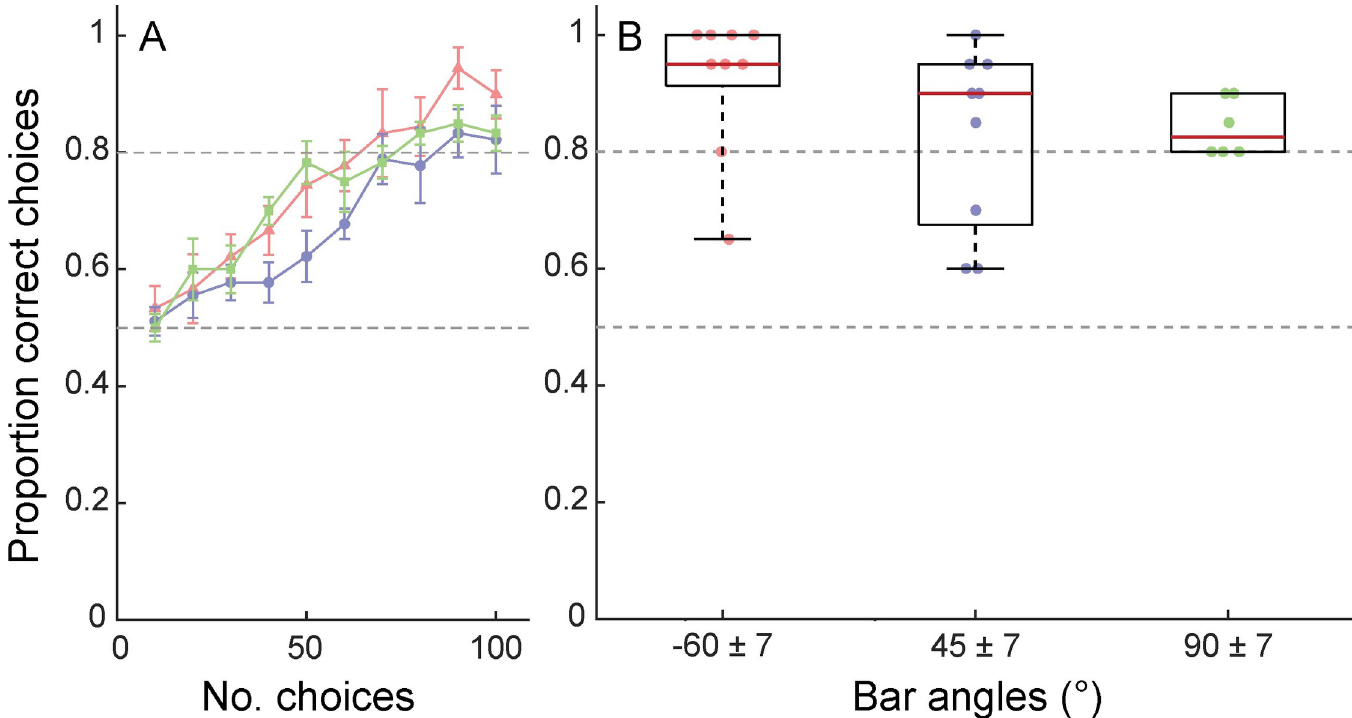
Fig 3. Angular discrimination is unaffected by training bar angles, in multiple-choice tests. A: Mean proportion of choices ( ± S.E.) for the trained angle, A , across each block of 10 consecutive choices for bees in experiment 1. Red triangles indicate bees that were trained to discriminate bars of -60˚ ± 7˚ (N = 9); blue circles, bees trained on 45˚ ± 7˚ bars (N = 9); green squares, bees trained on 90˚ ± 7˚ bars (N = 6). Dashed grey horizontal lines indicate a chance level of performance (0.5) and and the threshold criterion we used as a proxy for the end of the learning period (0.8 but note that bees had to reach this proportion of correct choices over 20 feeder visits). B: Proportion of choices for angle A (correct choices) across the last 20 feeder visits by bees trained to each group of angular orientations. Red lines indicate group median, boxes indicate the interquartile range and whiskers indicate the range. Filled circles show the proportion of choices for angle A , made by each individual. There are no significant differences between